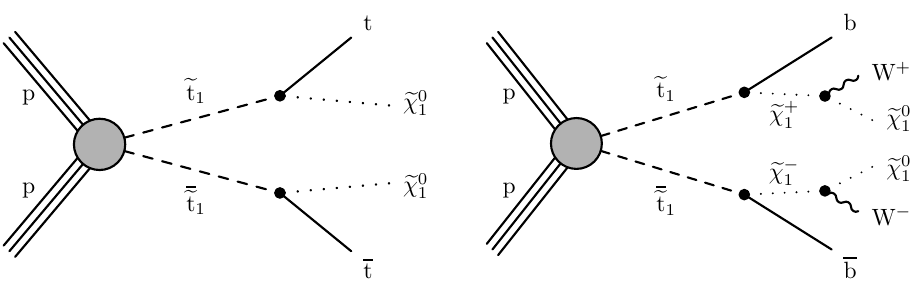
Figure 2 . Simpli(cid:12)ed-model diagrams of top squark pair production with two benchmark decay modes of the top squark: the left plot shows decays into a top quark and the lightest neutralino, while the right one displays prompt decays into a bottom quark and a chargino, further decaying into a neutralino and a W